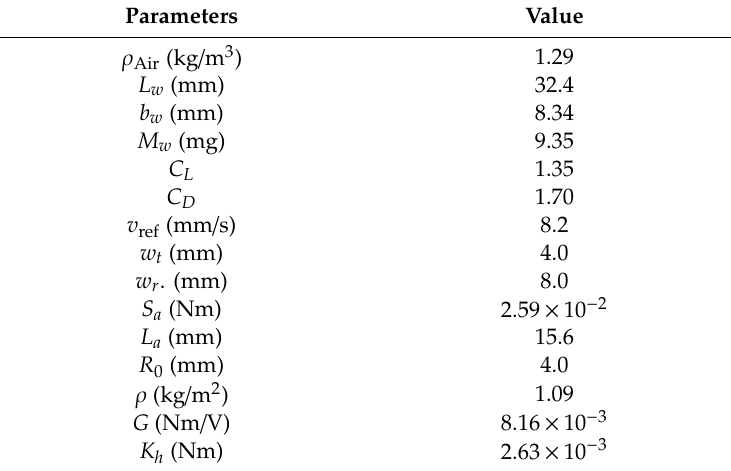
Table A1. Parameters used in the theoretical